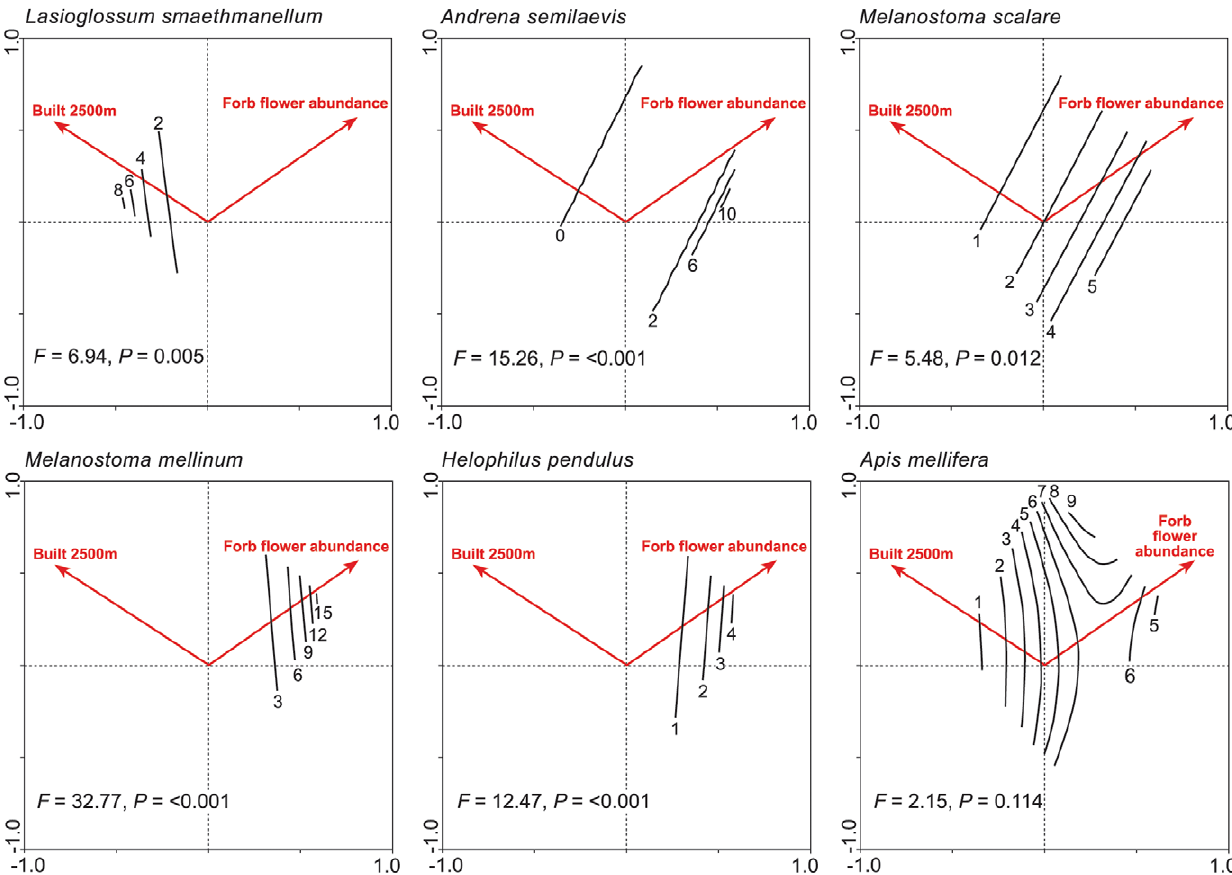
Figure 5. Output from the ordination generalized linear models for six pollinator species. Contours on the plots refer to the predicted abundance values of each species. Vectors are related to the significant explanatory